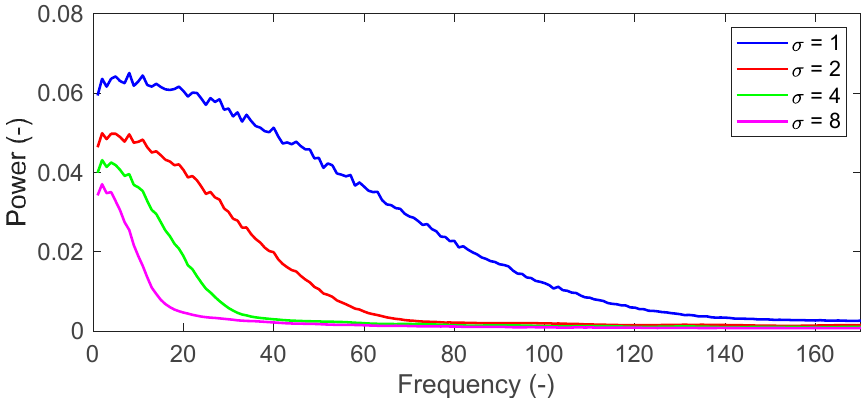
Figure 3. Frequency characteristics of the Gaussian filter.